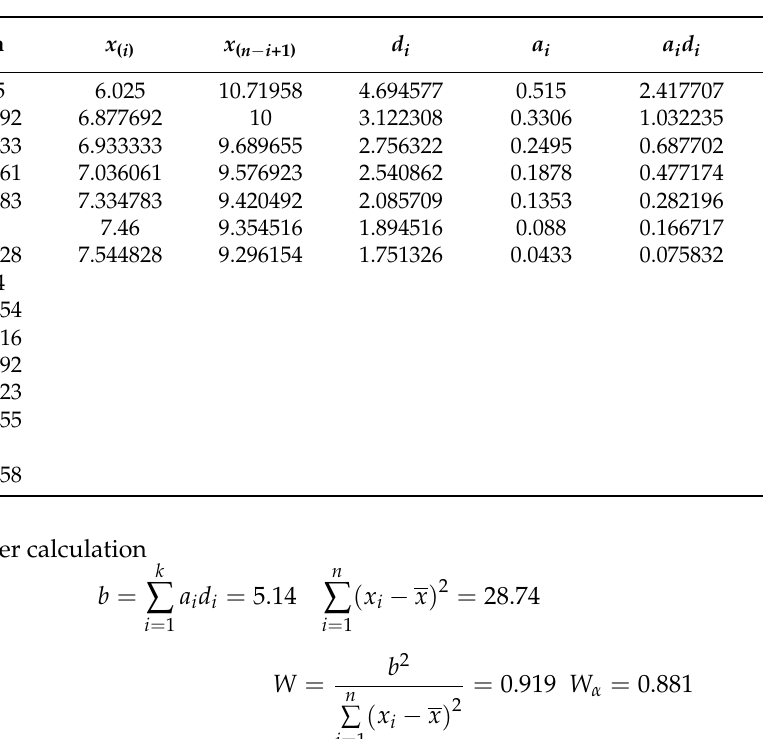
Table 1. Distribution test of ballast lateral resistance at 2 mm through the SW